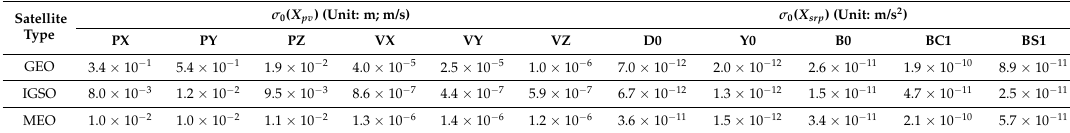
Table 2. Average a posteriori STD of PV and SRP parameters of LSQ solutions.